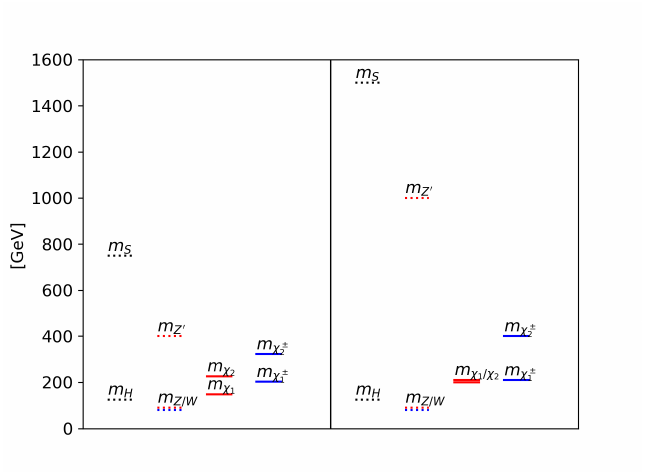
Figure 1: Two representative model spectra which give the correct relic density. The left spectrum shows a scenario with large mixing in both the neutral and charged fermion sectors, and is ruled out by direct detection constraints. The right spectrum is allowed by direct detection and dijet constraints and will be used as benchmark point [ 3 ] in Section